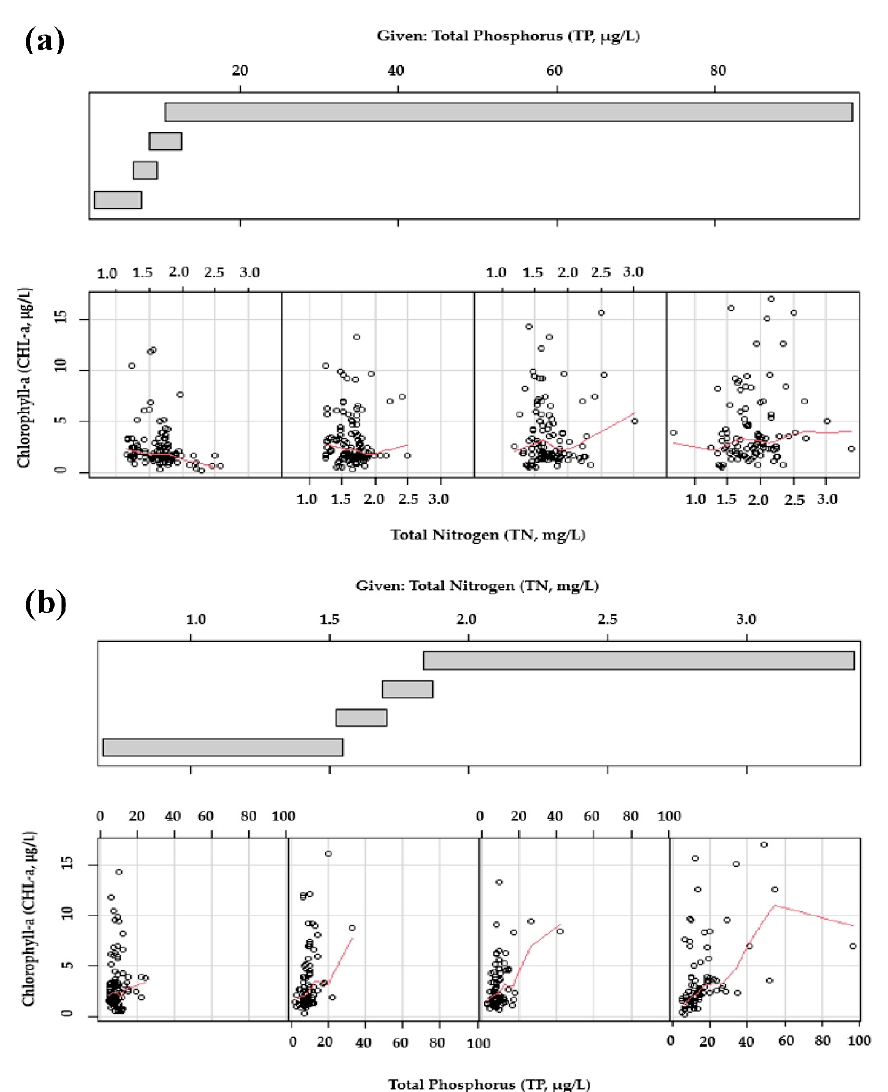
Figure 4. Conditional plots on each range of TP ( a ) and TN ( b ) for relationships between CHL-a vs. TN, and CHL-a vs. TP.